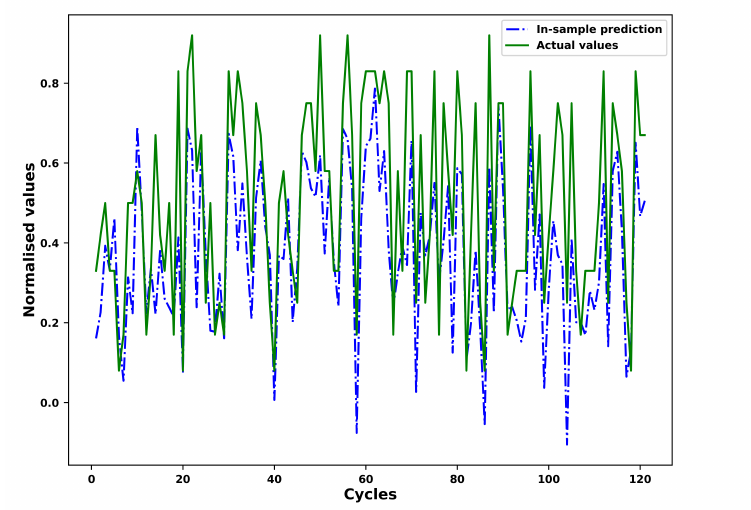
Figure 8. In-sample fitting of the second operational conditions of the unit 37 in FD001 test sets based on the FGM(1, 1) and ARIMA/ARMA